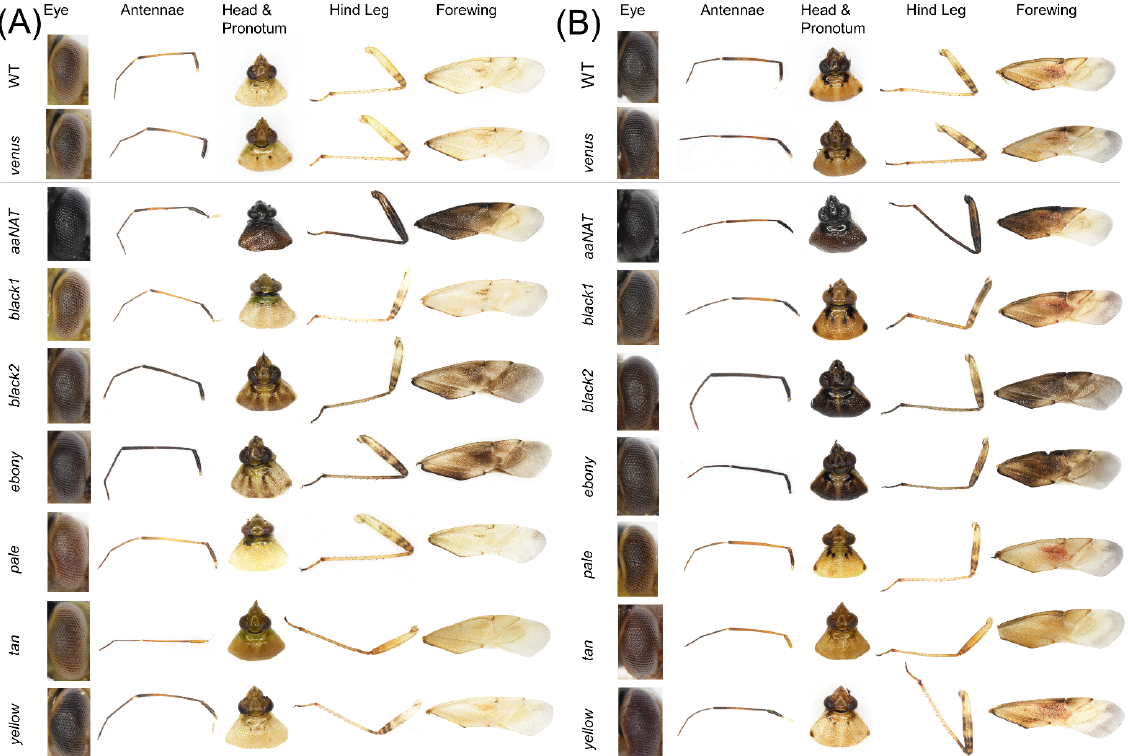
Figure 7. Effects of RNA interference-mediated knockdown on Lygus hesperus cuticle coloration of individual body parts. Shown are the eyes, antennae, pronotum and head, rear right leg, and right forewing of ( A ) female and ( B ) male L. hesperus adults at 7 days post-eclosion that were either untreated wildtype (WT) or injected as fifth instars with dsRNA of the control gene venus , or the indicated cuticle pigment-associated gene. Images are representative of three biological replicates consisting of 40 bugs of each sex.